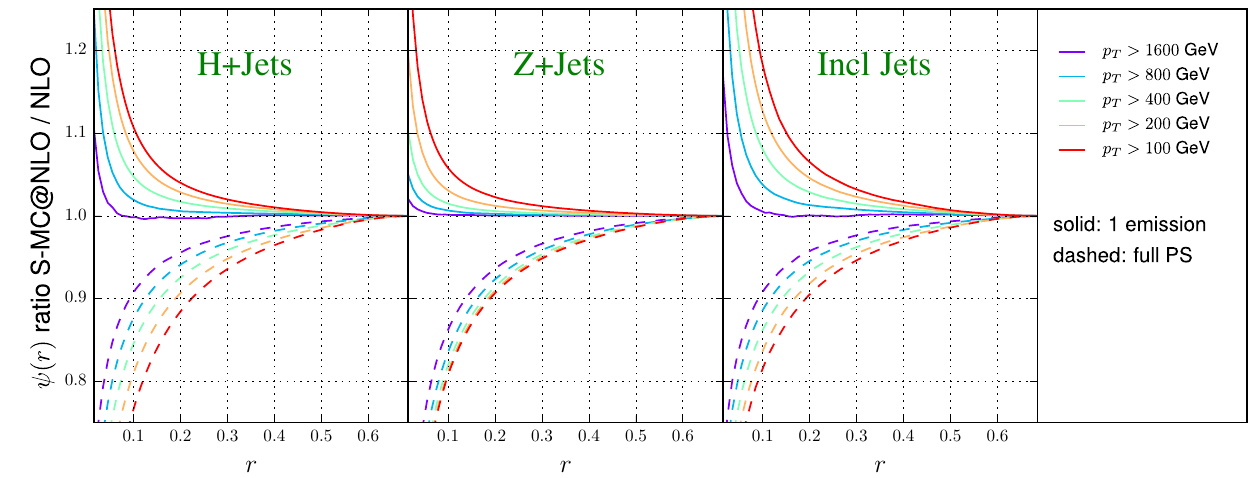
Fig. 1 Jet shapes for Higgs and Z plus jets and inclusive jets